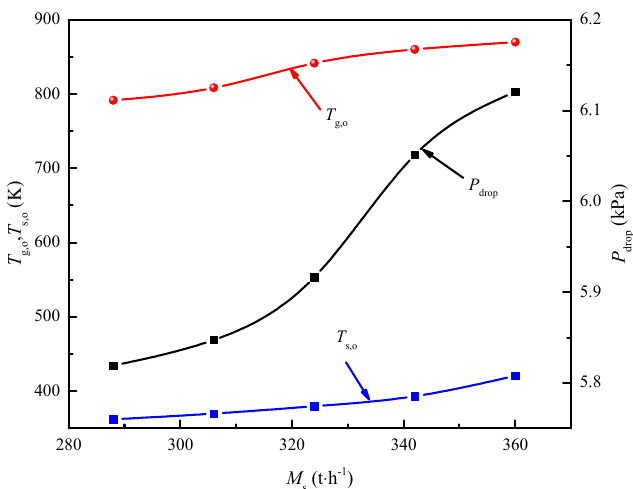
Figure 9. Effects of the sinter mass flow rate on the air and sinter outlet temperatures and pressure drop of cooling air.